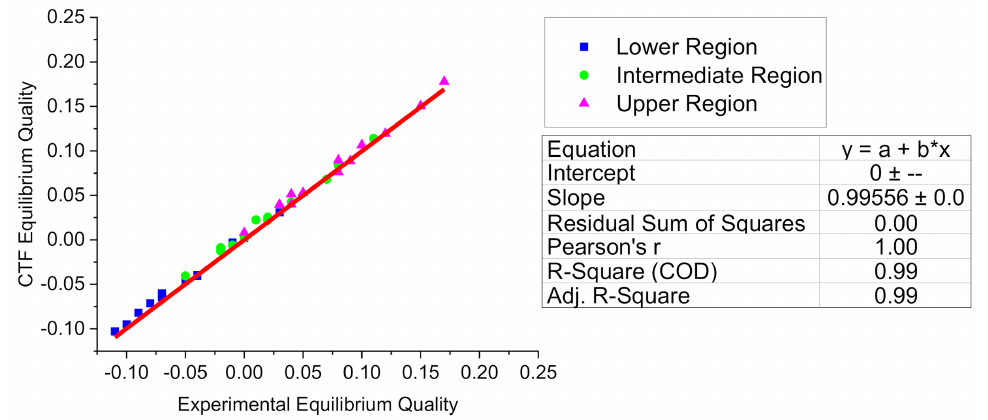
Figure A5. CTF vs. experimental equilibrium quality. Differences between the experimental and CTF equilibrium quality values at the three axial locations are small with slight overestimation of the lower region and intermediate region values and slight underestimation of the upper region values. Several reasons were found to cause the observed differences between the CTF and the experimental data: The gamma-ray transmission method used underestimates density, as these experimental measurements were taken at the centres of subchannels instead of near the heated surfaces where lower densities occur under general LWR behaviour. The nucleate-boiling model used affects the equilibrium quality as it may respond differently to the different initial and boundary conditions. The crossflow and mixing models used affect the equilibrium quality, codes which include crossflow as well as turbulent mixing models that achieve the best correlation between experimental measurements and code